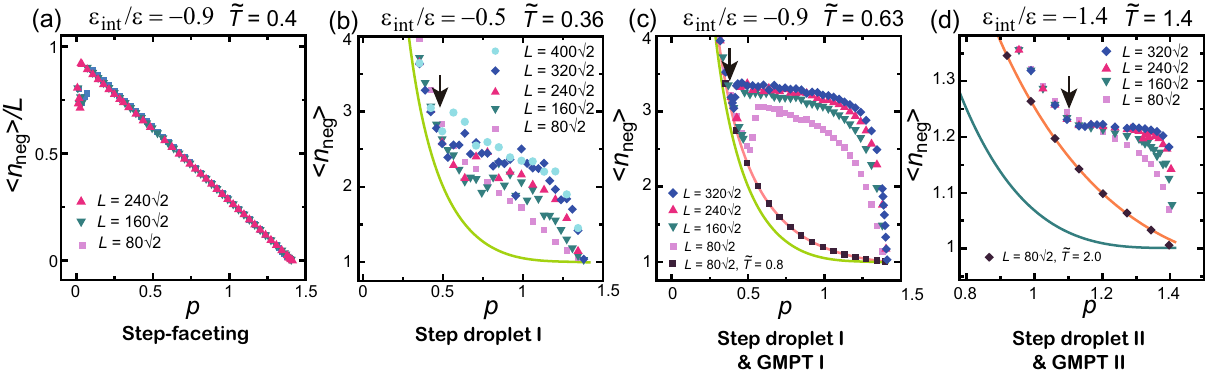
( √ 2 n neg n p )/ p 19 . Arrows: Figure 5. Slope dependence of the mean height of negative macrosteps � � = � � − 10 8 MCS/site. ( a ) Step-faceting 0.4633 , (c) p 1 0.3592 , ( d ) p 1 1.100 . The average is taken over 2 ( b ) p 1 × = = = 0.4 ). ( b ) Step droplet I zone. ( c ) Step droplet I zone and GMPT-I zone ( 0.8 ). k B T /ε k B T /ε T zone ( ˜ T ˜ = = = = 0 2.0 ). The light green lines in ( b ) and ( c ) are n neg ( d ) Step droplet II zone and GMPT-II zone ( ˜ T for ε int = = (cid:31) (cid:30) 0 at 0.4 (Eq. 7). The dark green line in ( d ) is T 1.4 (Eq. 8). The orange line in ( c ) is n neg at ˜ T for ε int ˜ = = = (cid:31) (cid:30) 0.9 at 1.4 at T 0.8 (GMPT-I) (Eq. 8). The orange line in ( d ) is T 2.0 n neg n neg for ε int for ε int ˜ ˜ = = = − = − (cid:31) (cid:30) (cid:31) (cid:30) (GMPT-II) (Eq. surface in the unshaded area in Fig. 2c has a homogeneous structure similar to that in the GMPT II zone. For p > p 1 , n becomes larger than for the smaller system size. (cid:31) (cid:30) Slope dependence of mean height of faceted negative macrosteps. A negative macrostep has (111) terraces and a n neg (001) side surface 19 . The mean height of negative macrosteps is obtained from the Monte Carlo results for (cid:31) (cid:30)